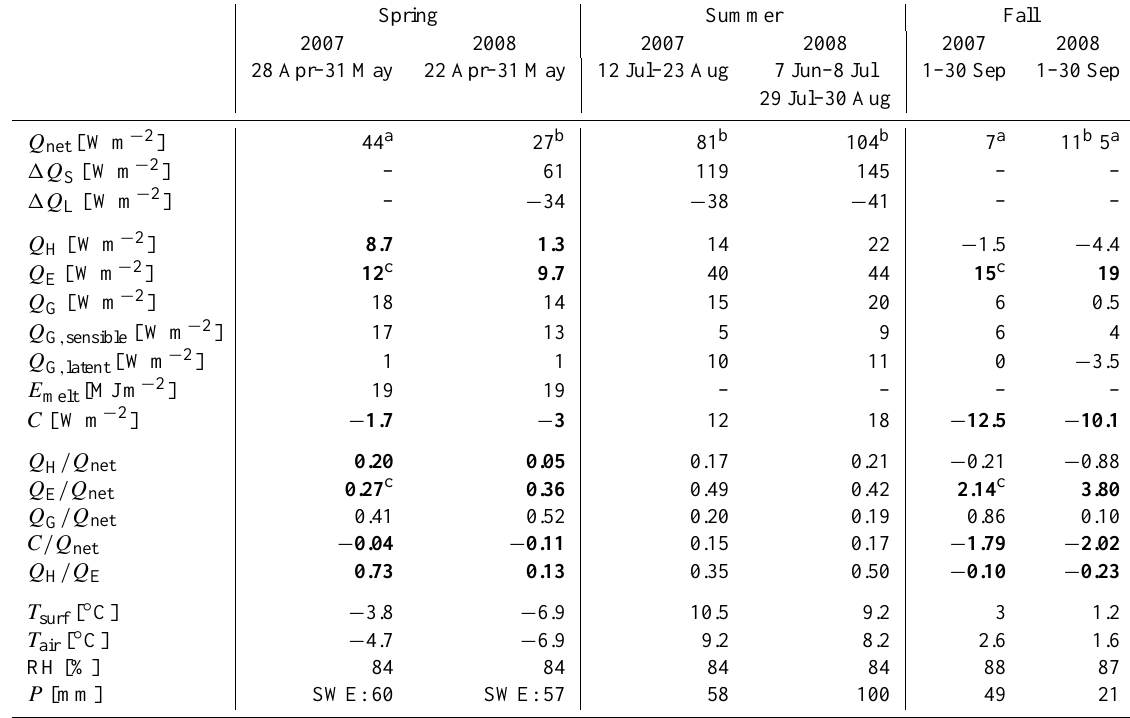
Table 2. Seasonal averages of the net radiation Q net , the net short wave radiation 1Q S , the net long wave radiation 1Q L , the sensible heat flux Q H , the latent heat flux Q E , the ground heat flux Q G , the sensible fraction of the ground heat flux Q G , sensible , the latent fraction of the ground heat flux Q G , latent , the energy attributed to snow melt E melt , and the closure term C . In addition, important ratios and climate parameters are given such as the surface temperature T surf , the air temperature T air , the relative humidity RH, and the total precipitation P . The springtime precipitation is replaced by the snow-water equivalent (SWE). The turbulent heat-flux values marked in bold are affected by minor data gaps, due to quality or lee-sector data